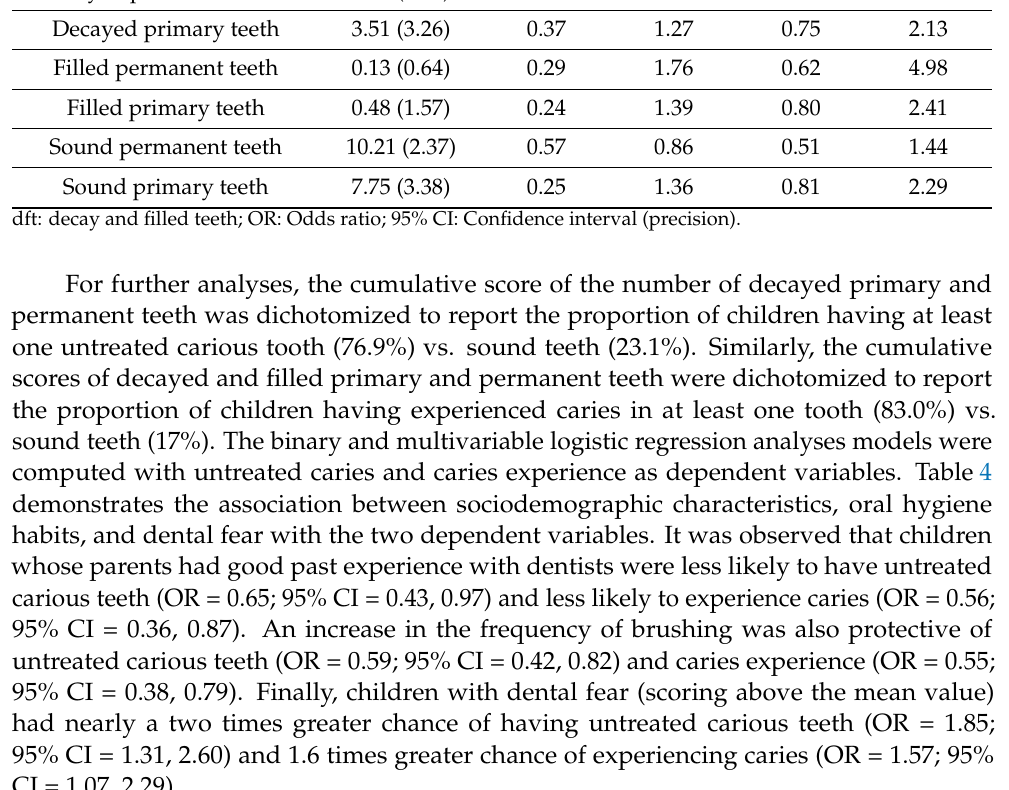
Dental Parameters (dft) Mean